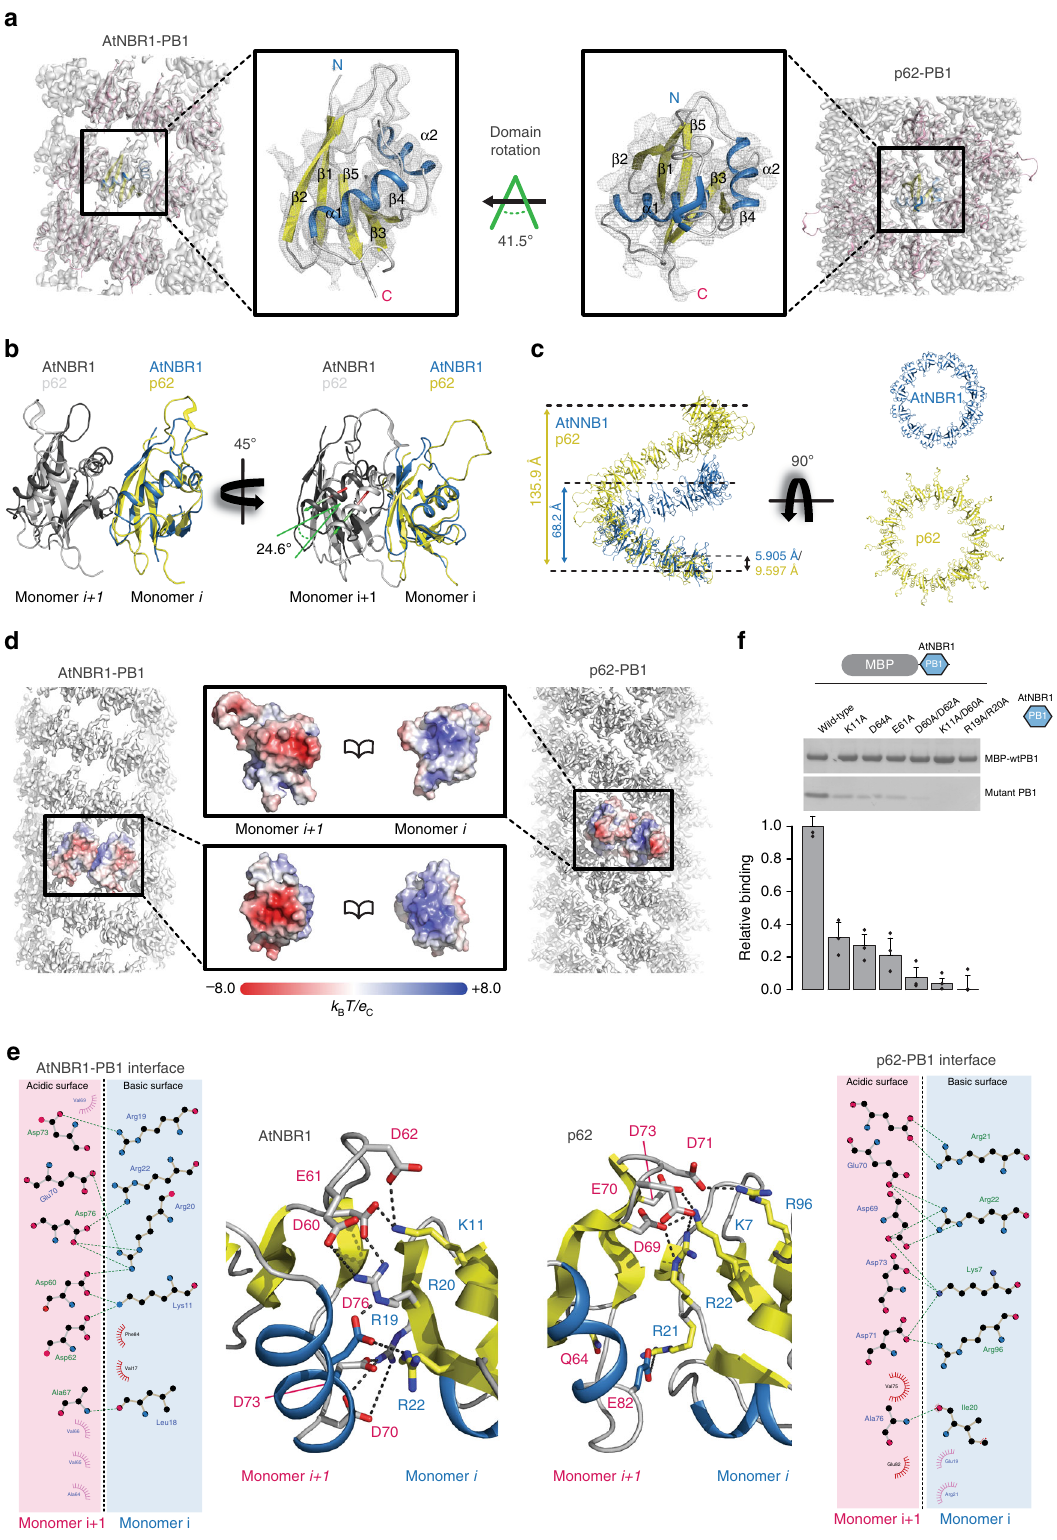
sequential tomogram slices (Fig. 5f). CLEM visualization of p62 bodies in cells under endogenous p62 levels con fi rms the presence of fi lamentous